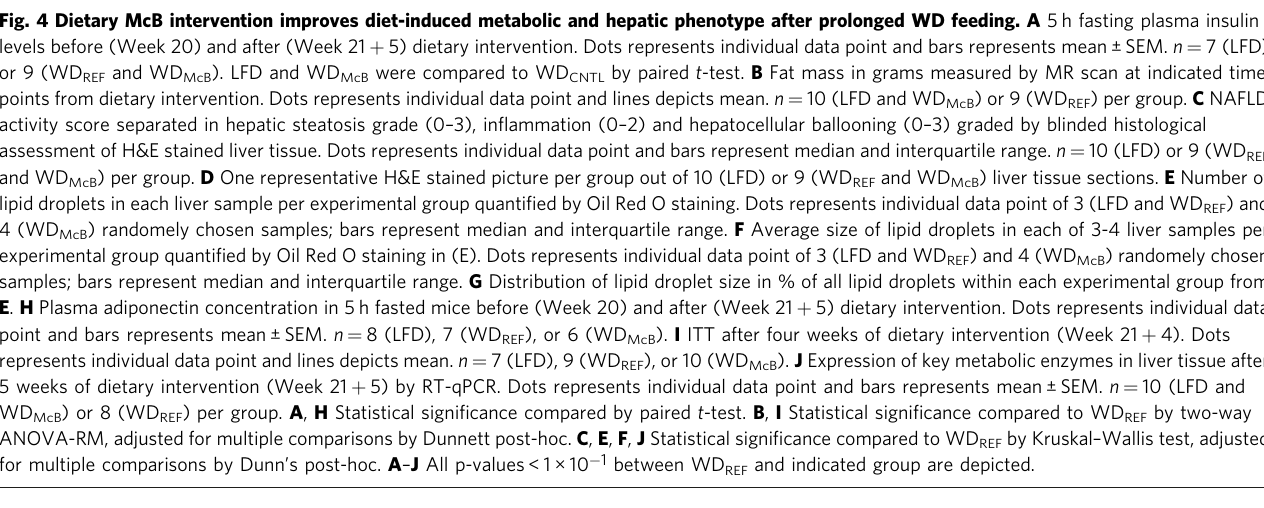
Fig. 4 Dietary McB intervention improves diet-induced metabolic and hepatic phenotype after prolonged WD feeding. A 5 h fasting plasma insulin levels before (Week 20) and after (Week 21 + 5) dietary intervention. Dots represents individual data point and bars represents mean ± SEM. n = 7 (LFD) or 9 (WD REF and WD McB ). LFD and WD McB were compared to WD CNTL by paired t -test. B Fat mass in grams measured by MR scan at indicated time points from dietary intervention. Dots represents individual data point and lines depicts mean. n = 10 (LFD and WD McB ) or 9 (WD REF ) per group. C NAFLD activity score separated in hepatic steatosis grade (0 – 3), in fl ammation (0 – 2) and hepatocellular ballooning (0 – 3) graded by blinded histological assessment of H&E stained liver tissue. Dots represents individual data point and bars represent median and interquartile range. n = 10 (LFD) or 9 (WD REF and WD McB ) per group. D One representative H&E stained picture per group out of 10 (LFD) or 9 (WD REF and WD McB ) liver tissue sections. E Number of lipid droplets in each liver sample per experimental group quanti fi ed by Oil Red O staining. Dots represents individual data point of 3 (LFD and WD REF ) and 4 (WD McB ) randomely chosen samples; bars represent median and interquartile range. F Average size of lipid droplets in each of 3-4 liver samples per experimental group quanti fi ed by Oil Red O staining in (E). Dots represents individual data point of 3 (LFD and WD REF ) and 4 (WD McB ) randomely chosen samples; bars represent median and interquartile range. G Distribution of lipid droplet size in % of all lipid droplets within each experimental group from E . H Plasma adiponectin concentration in 5 h fasted mice before (Week 20) and after (Week 21 + 5) dietary intervention. Dots represents individual data point and bars represents mean ± SEM. n = 8 (LFD), 7 (WD REF ), or 6 (WD McB ). I ITT after four weeks of dietary intervention (Week 21 + 4). Dots represents individual data point and lines depicts mean. n = 7 (LFD), 9 (WD REF ), or 10 (WD McB ). J Expression of key metabolic enzymes in liver tissue after 5 weeks of dietary intervention (Week 21 + 5) by RT-qPCR. Dots represents individual data point and bars represents mean ± SEM. n = 10 (LFD and WD McB ) or 8 (WD REF ) per group. A , H Statistical signi fi cance compared by paired t -test. B , I Statistical signi fi cance compared to WD REF by two-way ANOVA-RM, adjusted for multiple comparisons by Dunnett post-hoc. C , E , F , J Statistical signi fi cance compared to WD REF by Kruskal – Wallis test, adjusted for multiple comparisons by Dunn ’ s post-hoc. A – J All p-values < 1 × 10 − 1 between WD REF and indicated group